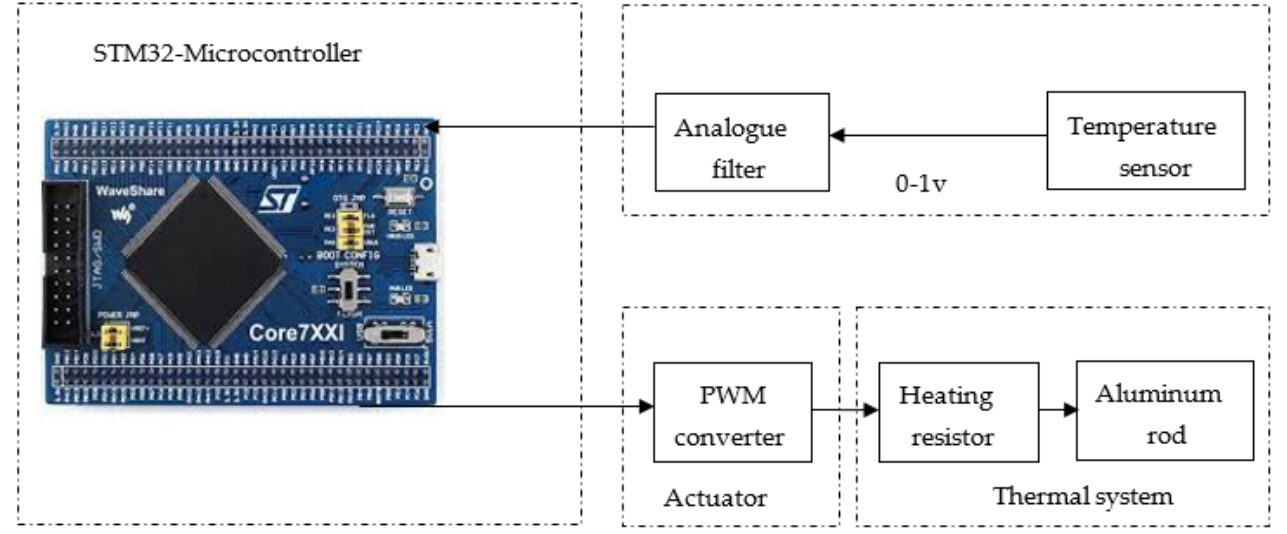
Figure 7. Illustrative diagram of the thermal process using an STM32 microcontroller.